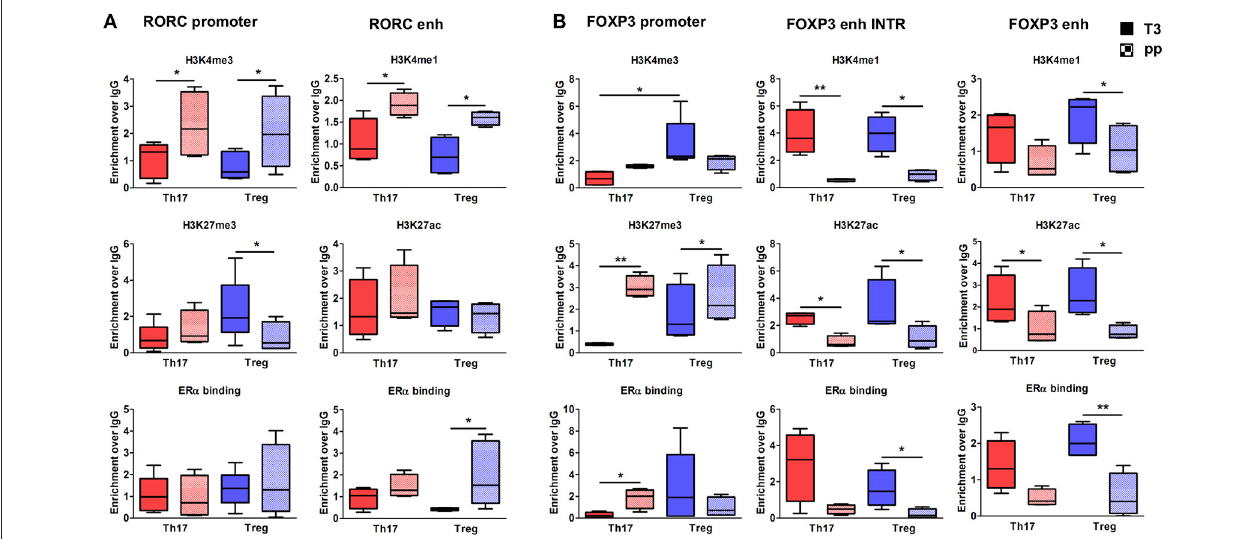
FIGURE 5 | Epigenetic changes at FOXP3 and RORC loci in Treg and Th17 purified from MS patients during pregnancy. ChIP-qPCR analysis of H3K4me3, H3K27me3, H3K4me1, H3K27ac, and ER α binding performed at RORC - (A) and FOXP3 -CSRs (B) in Th17 (red) and Treg (blu) cells, derived from MS patients during third trimester of pregnancy T3 (filled texture) and during the post-partum pp (squared texture) phase. Boxes, with mean, minimum and maximum, represent the enrichment of the immunoprecipitation over non-specific IgG and normalized for input chromatin. * p < 0.05 and ** p < 0.01 represent the statistical